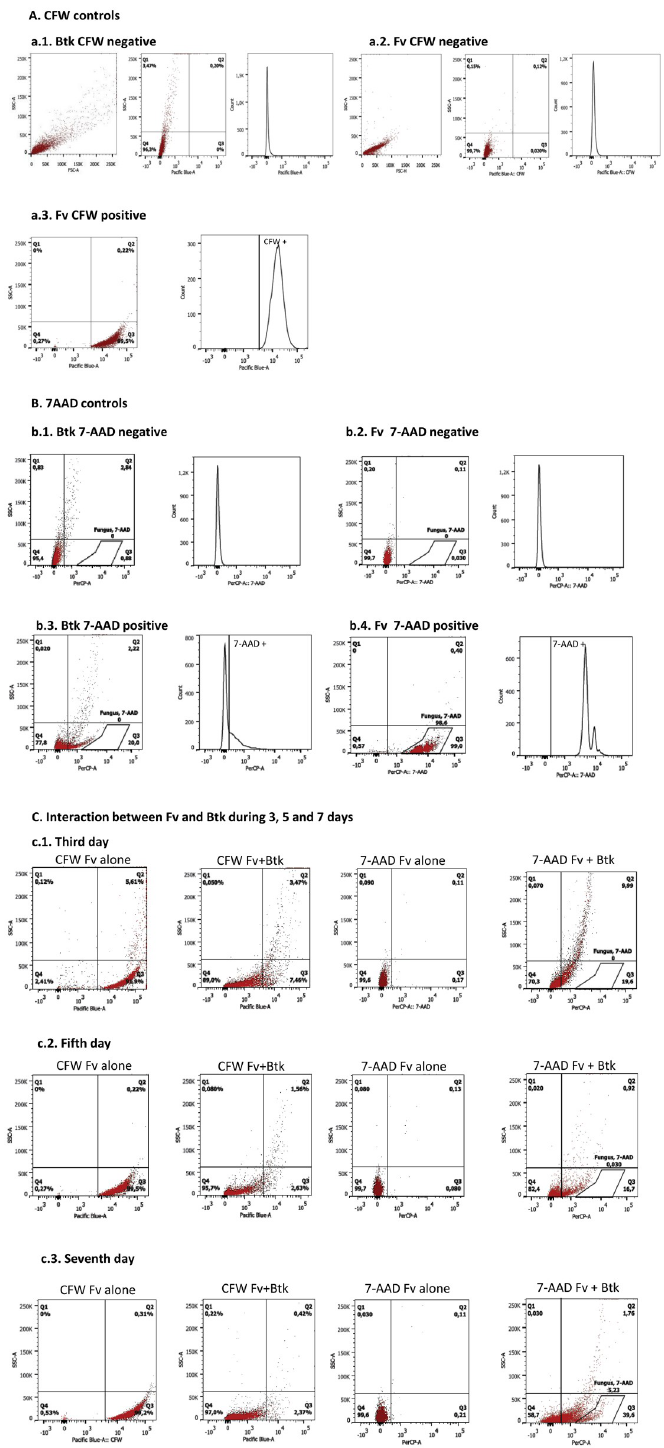
Fig 2. Flow cytometry analysis for Bacillus thuringiensis subsp. kurstaki (Btk) interacting with Fusarium verticillioides (Fv). Histograms show the number of cells versus the fluorescence intensity. Dot plot graphs show the cell size (SSC) versus the cellular complexity and the SSC versus the fluorescence intensity. The vertical lines define the baseline above which the fluorescence is positive. Figure 2(A) . Calcofluor White (CFW) controls and their respective histograms: negative, Btk stained with CFW (a.1); negative, Fv cells not stained with CFW (a.2); and positive, fungal